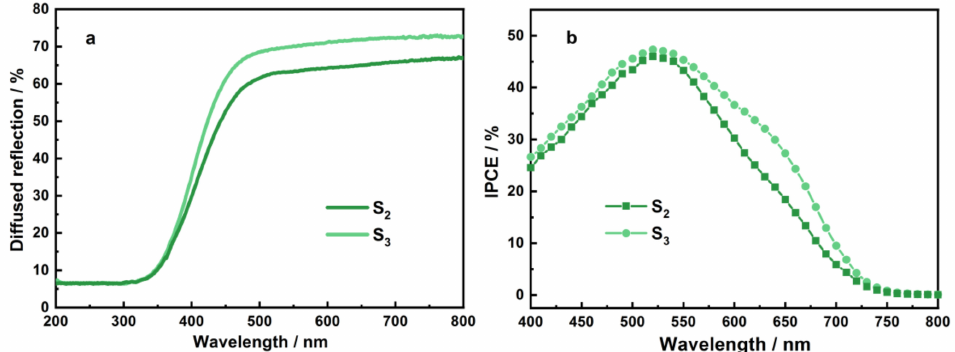
Figure 3. ( a ) Diffuse reflectance spectra and ( b ) IPCE spectra of the different electrodes.